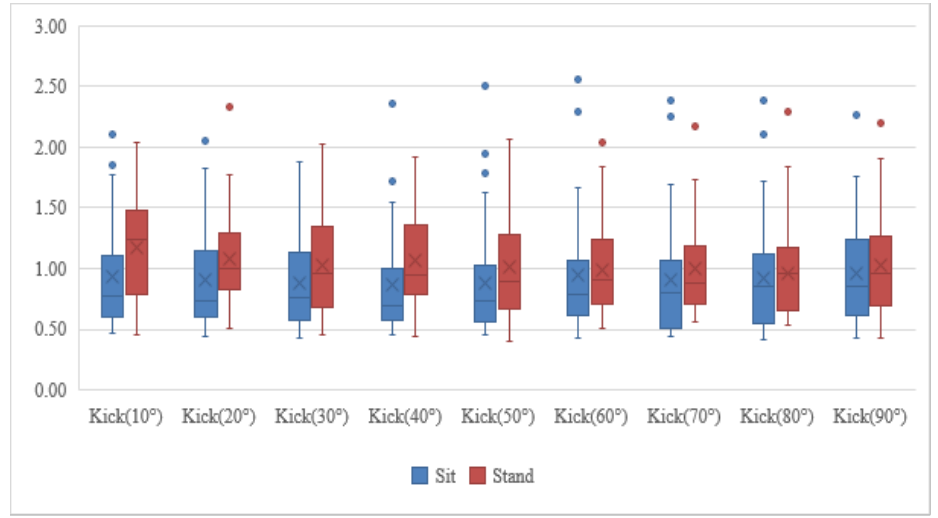
Figure 5. The box plot of kick action average value of 38 female subjects sitting and standing at 10°~90°.